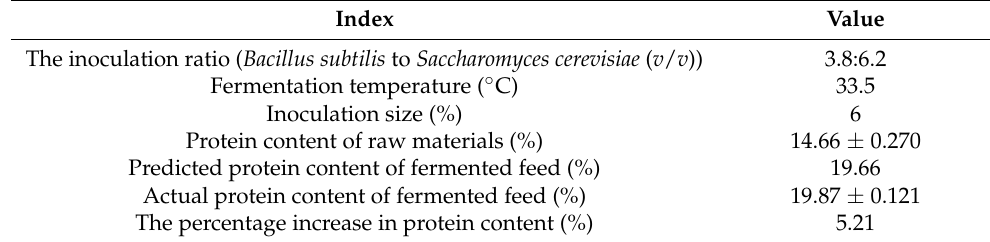
Table 11. The optimization results for the feed fermented with the compound probiotics. Index Value The inoculation ratio ( Bacillus subtilis to Saccharomyces cerevisiae ( v / v ))